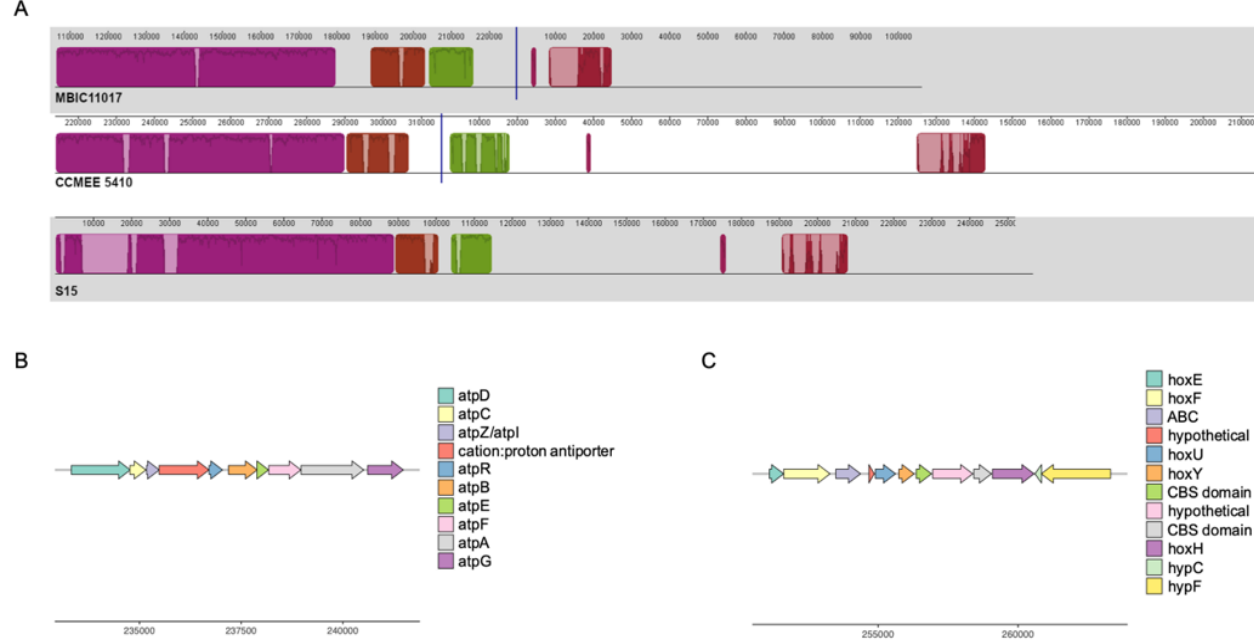
Figure 3. ( A ). Multiple alignment of plasmids from A. marina strains MBIC11017, CCMEE 5410, and S15 encoding sodium-transporting ATPase and bidirectional hydrogenase genes. Homologous blocks of aligned sequence share the same color, with missing DNA transparent. Traces within blocks indicate sequence similarity. ( B ). Gene map of the sodium-transporting ATPase region for A. marina CCMEE 5410. ( C ). Gene map of the bidirectional hydrogenase region for A. marina CCMEE 5410.